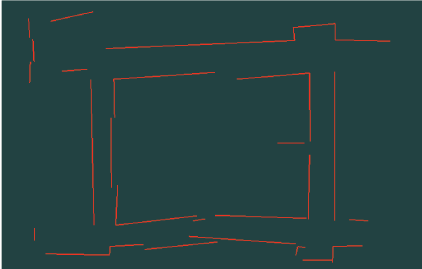
Figure 7: Drawing effect of using 10 particles by the proposed method.